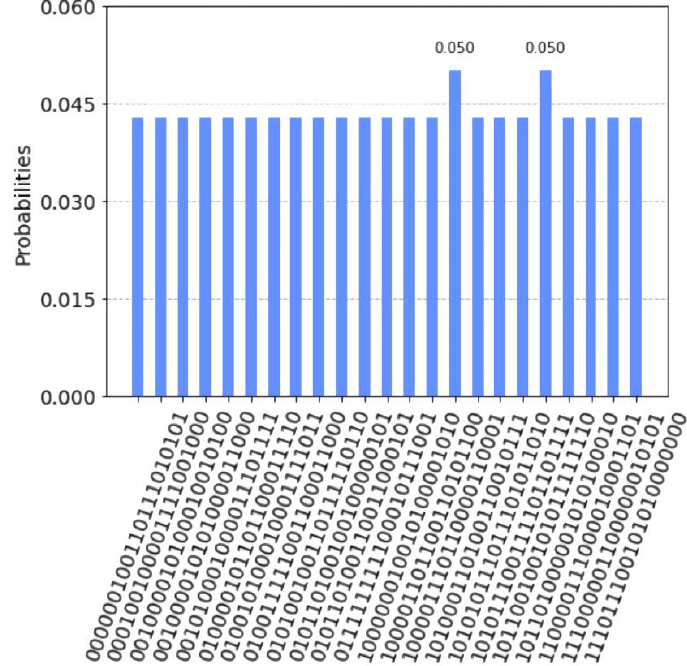
Figure 12. The result of one iteration of the twenty-one variable Boolean equation system.